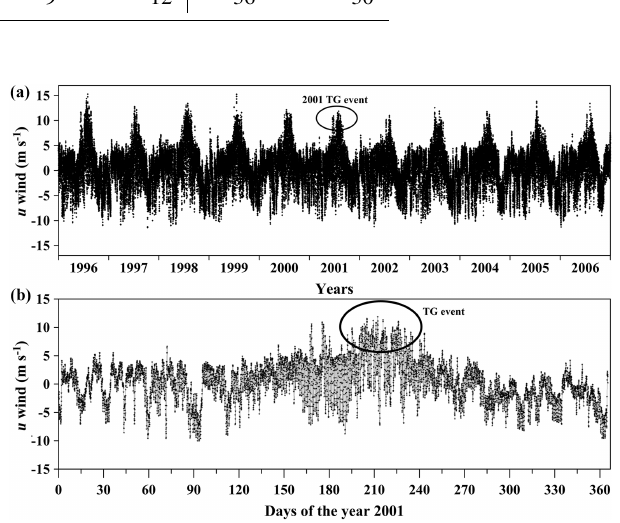
Figure 7. The u component of the CFSR hourly surface wind near the Tokar region (38.5 ◦ E, 18.5 ◦ N) (a) from 1996 to 2006 and (b) for the year 2001. The ellipse indicates the TG event in the year